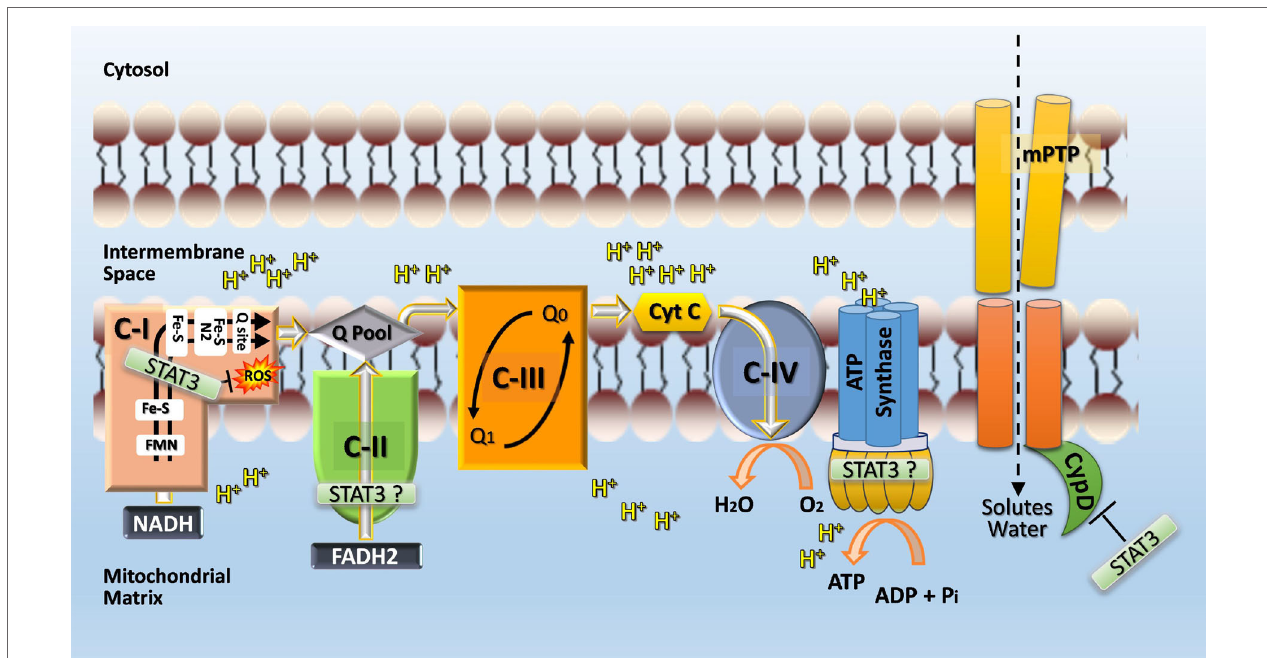
FiGURe 4 | Postulated role of STAT3 in mitochondria . STAT3 may function directly or indirectly (e.g., by serving as a scaffolding protein for the posttranslational modification of a subunit protein) as a rheostat to ensure complex I function and prevent excessive ROS production, which would feedback and cause damage to complex I. STAT3 may also interact with cyclophilin D and thereby prevent opening of the mitochondrial permeability transition pore (mPTP) and subsequent disruption of mitochondrial integrity and function through the influx of solutes and water. Additional sites within the ETC where STAT3 may have positive functional actions, include complex II and ATP synthase (complex V). A possible engagement of STAT3 with complex V is postulated based on the observation that complex V activity is markedly reduced with STAT3 loss in Ras-transformed cells (120) and recent evidence identifying mPTP as the c-subunit of the F 1 F O ATP synthase